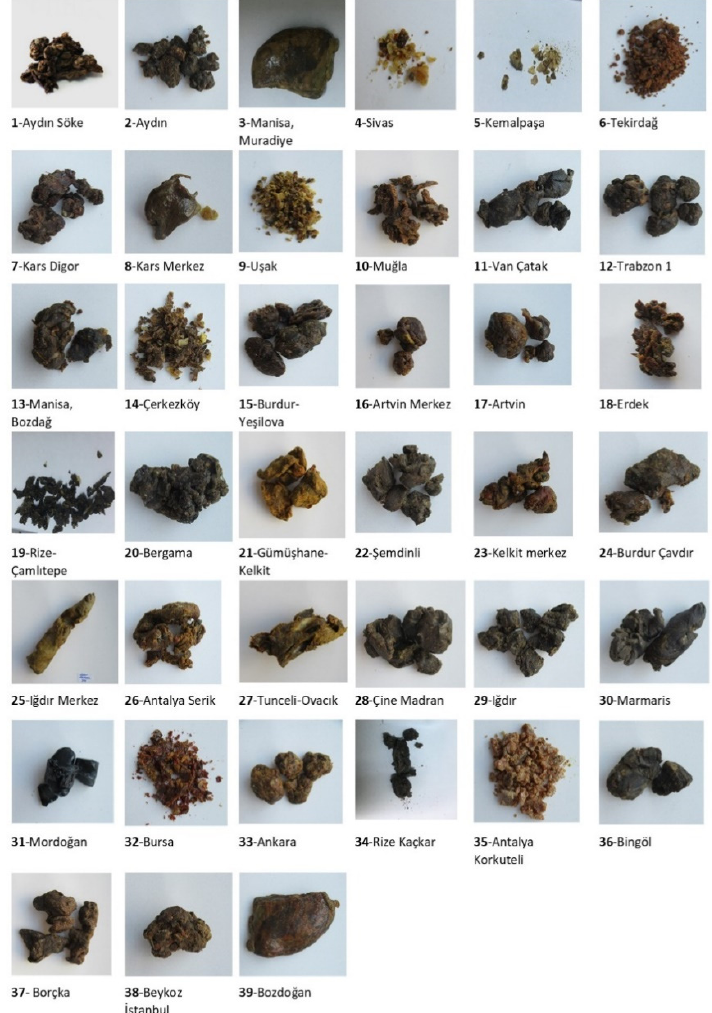
Figure 2. The color variety of the raw propolis samples collected from different geographical locations in Turkiye.